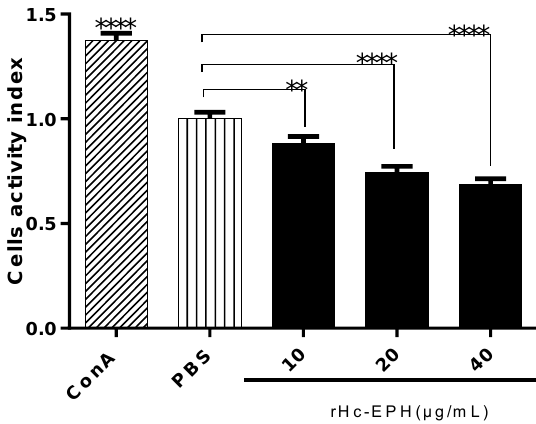
Figure 4. Effects of rHcEPH on PBMCs activity. PBMCs were treated with serial concentrations of rHcEPH, PBS (Negative control) and ConA (Positive control) for 72 h. Cell activity index was calculated with the OD 450 values in PBS control considered as 100%. The data is expressed as mean ± SEM of three independent experiments (** p < 0.01, **** p < 0.0001).